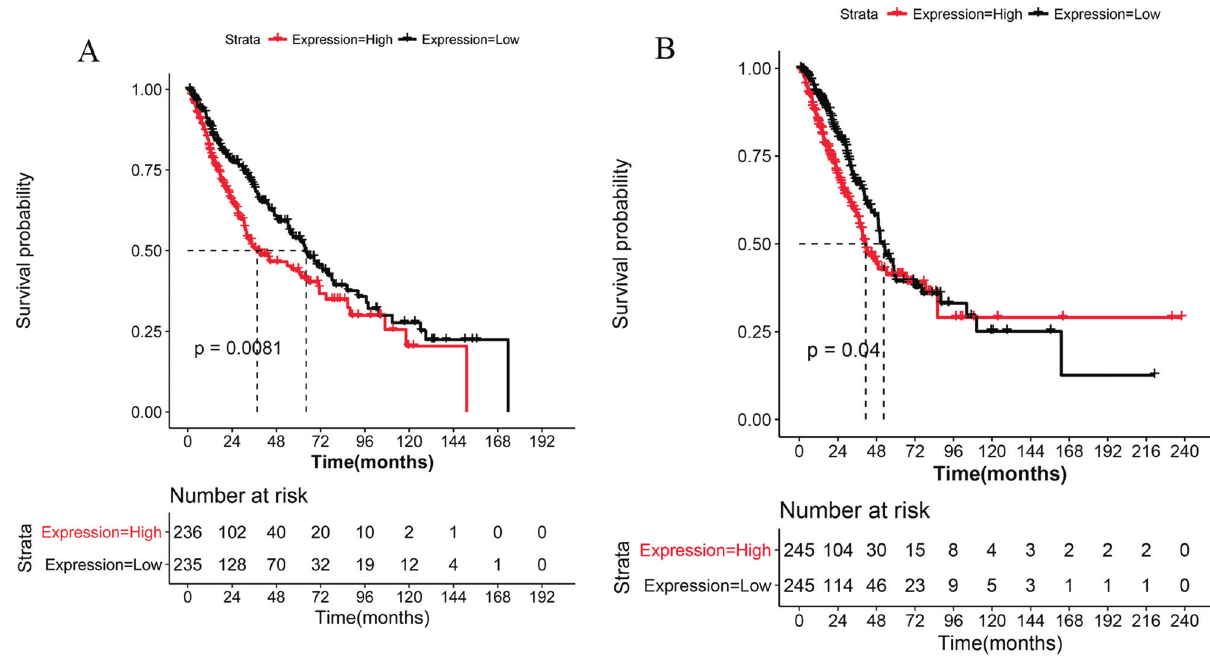
Figure 5 - The survival curve of EPHA2 (A) and CDK6 (B). Red line represents high risk group and black line denotes low risk